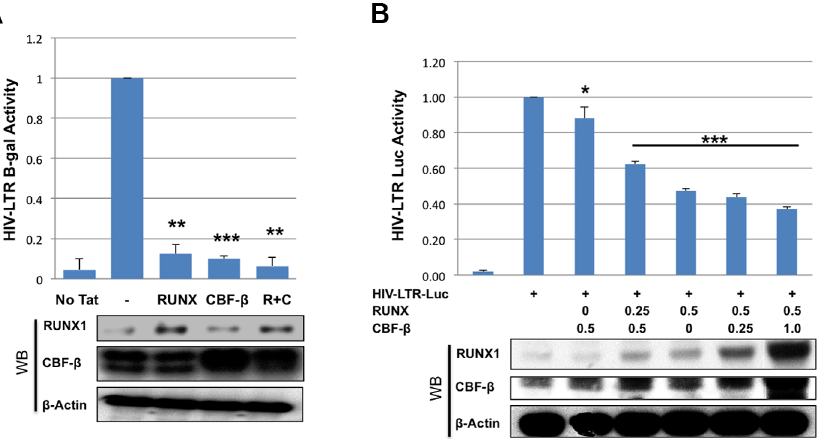
Figure 2. RUNX1 and CBF- b suppress LTR-driven promoter expression of the integrated and unintegrated LTR. A ) TZMbl indicator cells were seeded in a six well plate and transfected with 0.01 m g Tat expression vector and 1 m g of RUNX1 or CBF- b expression vectors or a combination of the two. Forty-eight hours after transfection cells were lysed and b -galactosidase activity was measured by a luminescence assay. b -galactosidase is represented as relative to transfection of Tat alone. B ) 293T cells were seeded in a 6-well plate and transfected with pLTR-GL3 and RUNX1 or CBF- b vectors as indicated. Forty-eight hours after transfection the cells were harvested and cell lysates prepared. Cell extracts were then used to determine the production of luciferase. Results are displayed as luciferase signal relative to transfection of reporter construct alone. Western blotting was performed on transfected cells to assess the levels of RUNX1 and CBF- b expression. * p # 0.05, ** p # 0.01 and *** p # 0.001